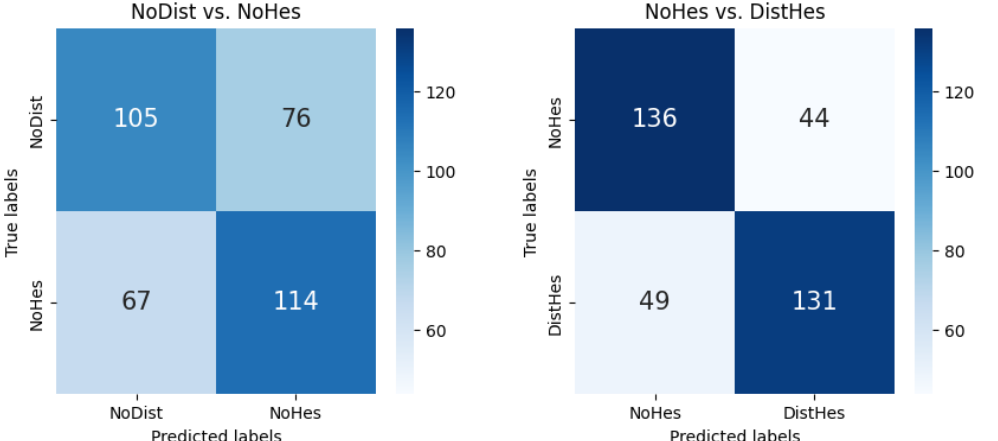
Figure 5. Confusion matrix for 1-second EEG windows of the ambient and distraction conditions and the distraction and hesitation conditions averaged over all folds of the 10-fold cross-validation and all participants. The color bar denotes the amount of 1-second